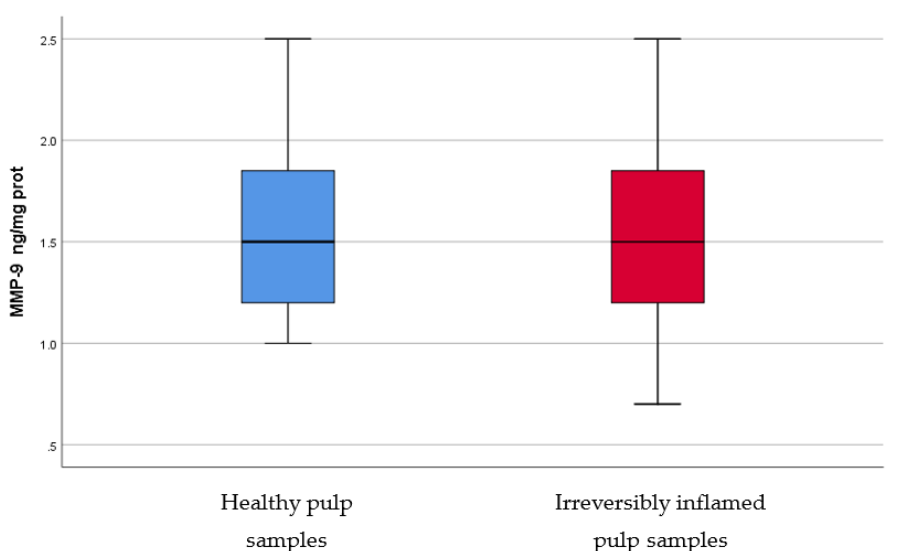
Figure 9. Comparison of MMP-9 levels (ng/mg protein) in healthy and irreversibly inflamed dental pulp samples, respectively. The distribution of variables is parametric in both groups according to the Shapiro–Wilk test ( p > 0.05). The control group showed higher levels of MMP-9 compared to the experimental group, but, according to Student’s t -test, differences between the two groups are not statistically significant ( p = 0.625).